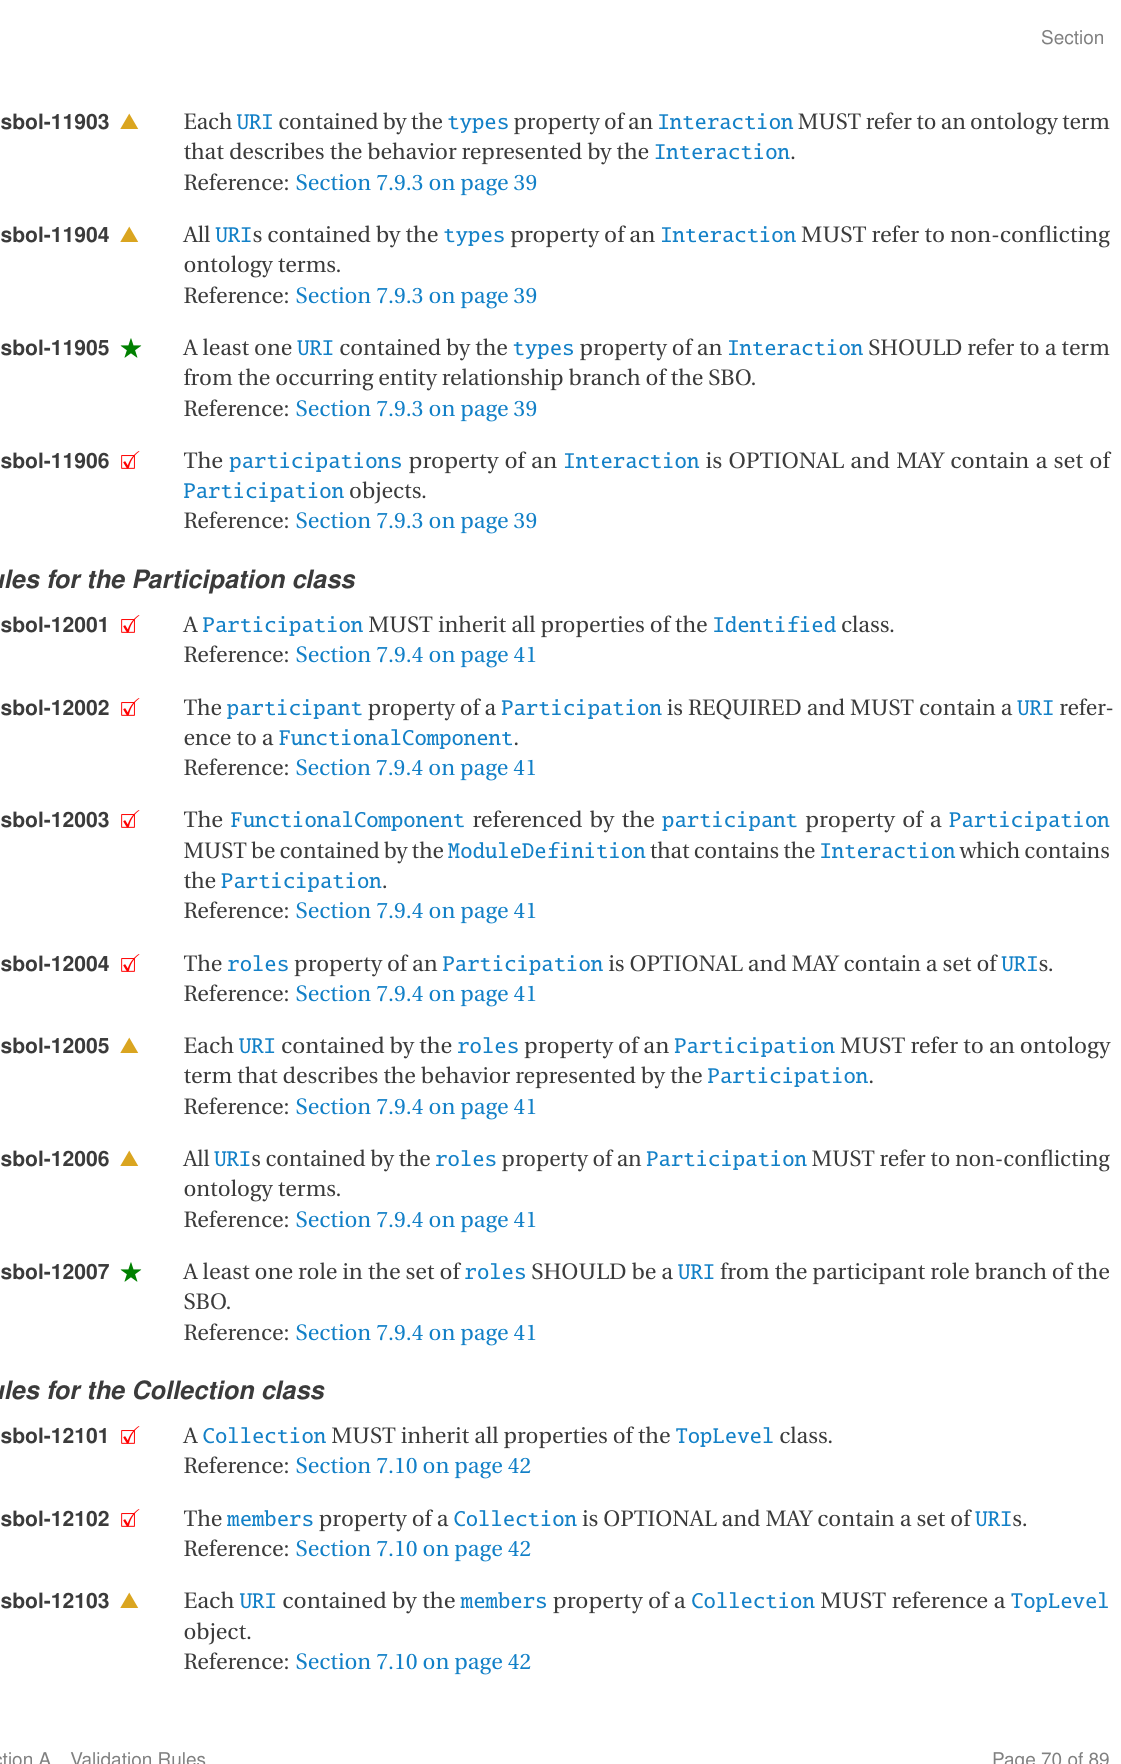
Section A Validation